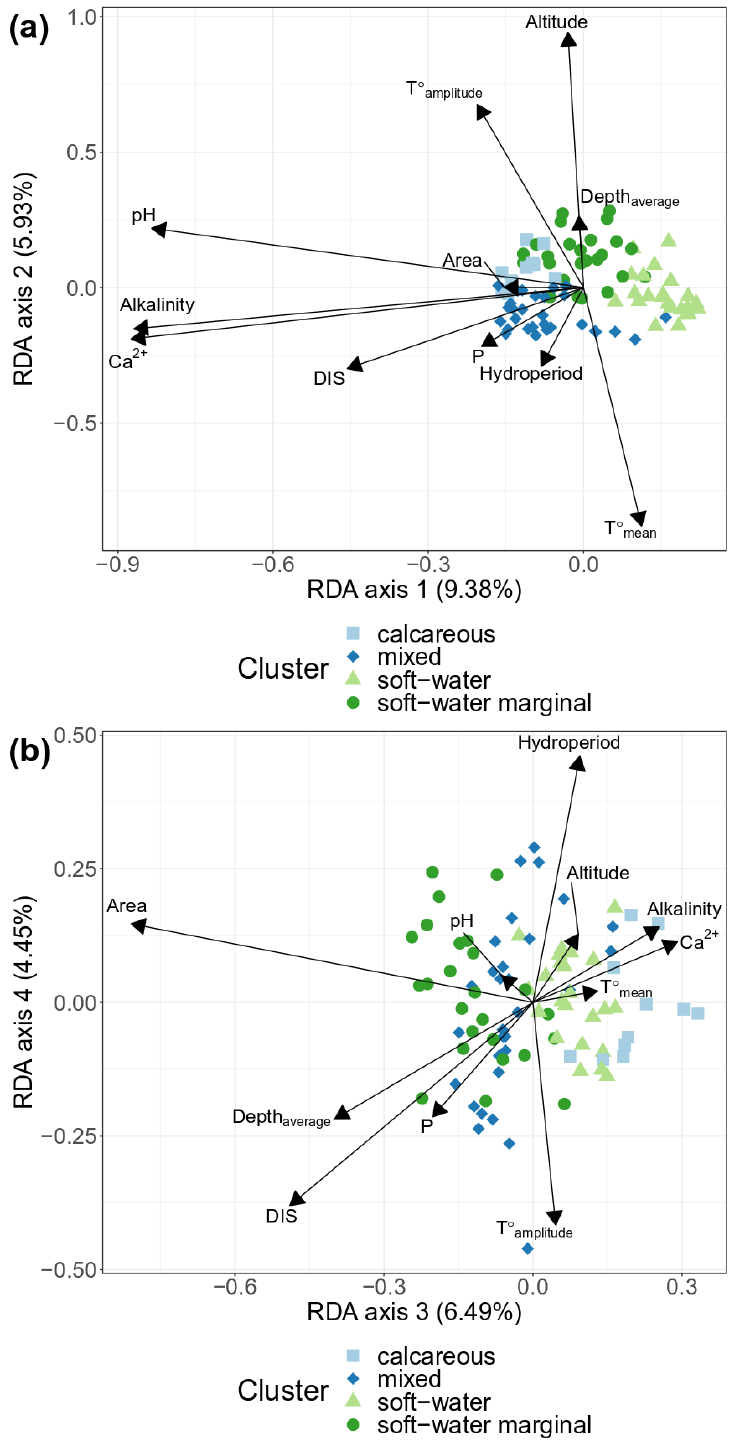
Figure 4. Distance-based redundancy analysis (db-RDA) ordination plots of macrophyte abundance based on taxonomic composition against forward selected environmental variables (black arrows) at 89 stations sampled from 2013 to 2018. ( a ) = Axis 1 and Axis 2, ( b ) = Axis 3 and Axis 4. Explained variance (Pr < 0.001) for each axis are indicated in parenthesis at each legend axis. Colors and point shape represent the 4 groups defined by cluster partition (soft-water, soft-water marginal, mixed, and calcareous). Area = surface area, DIS = distance from the source, P = total phosphorus in water, T amplitude = air annual temperature amplitude, T mean = air mean annual temperature.